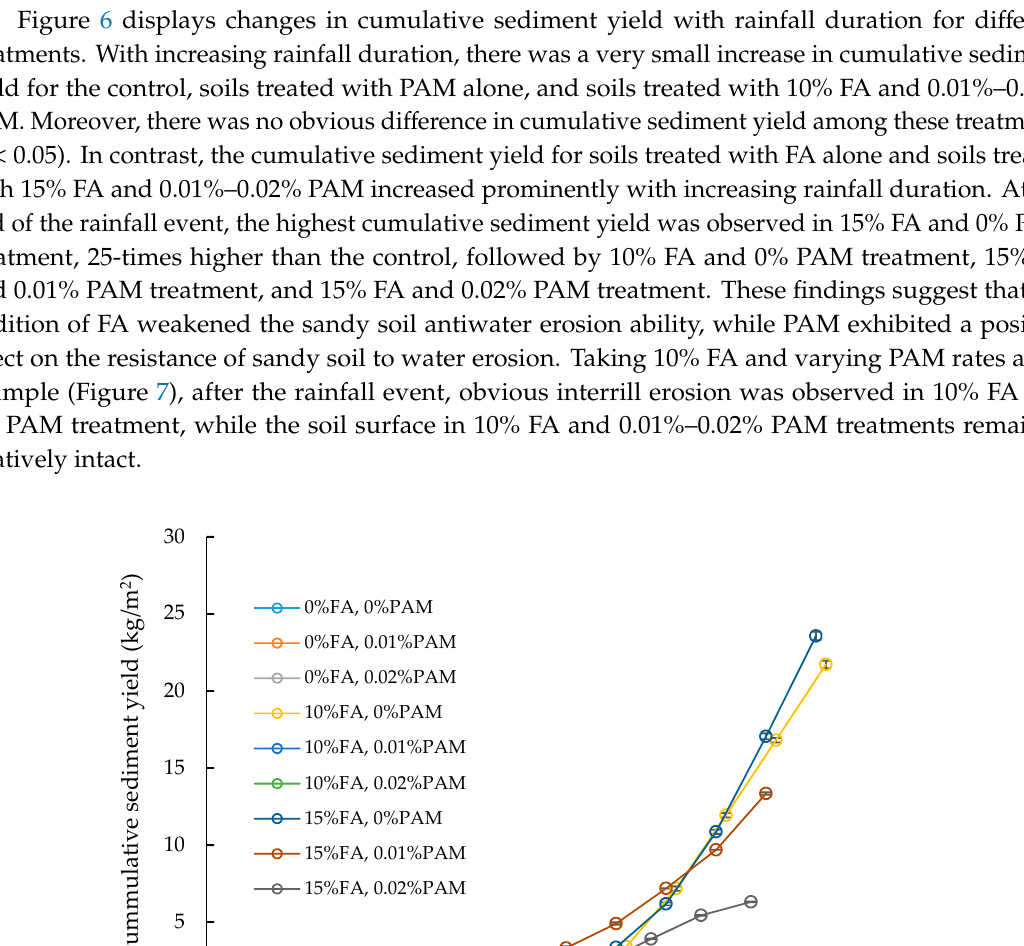
Figure 5. Changes in instantaneous sediment yield rate with rainfall duration for different treatments. The error bars represent one standard deviation ( n = 3).